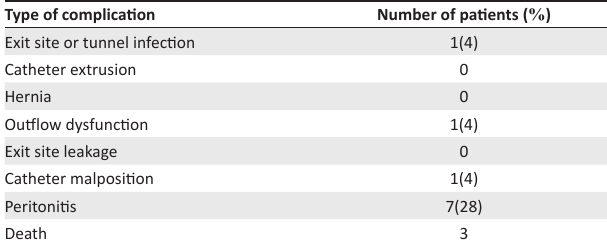
TABLE 3: Complications from >30 days – 1